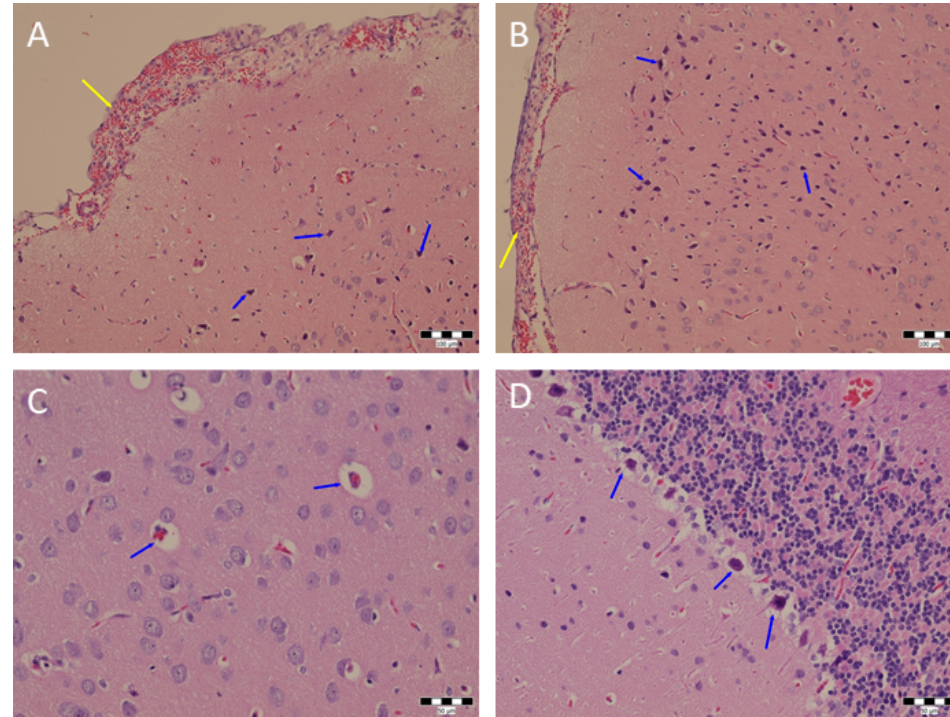
Figure 5. Histological analysis of brain tissue stained with hematoxylin and eosin. Hemorrhage in the meninges of the hemisphere (yellow arrow). Some of the dark neurons in the cortex are indicated with blue arrows ( A ). Hyperemia and hemorrhage in the meninges of the cerebral hemisphere (yellow arrow). Some of the dark neurons in the cortex are indicated with blue arrows ( B ). Pericapillary edema in the cortex of the hemisphere (blue arrows) ( C ). Dark neurons in the Purkinje cell zone in the cerebellum. Some of them are marked with blue arrows ( D ). Scale bar 100 µ